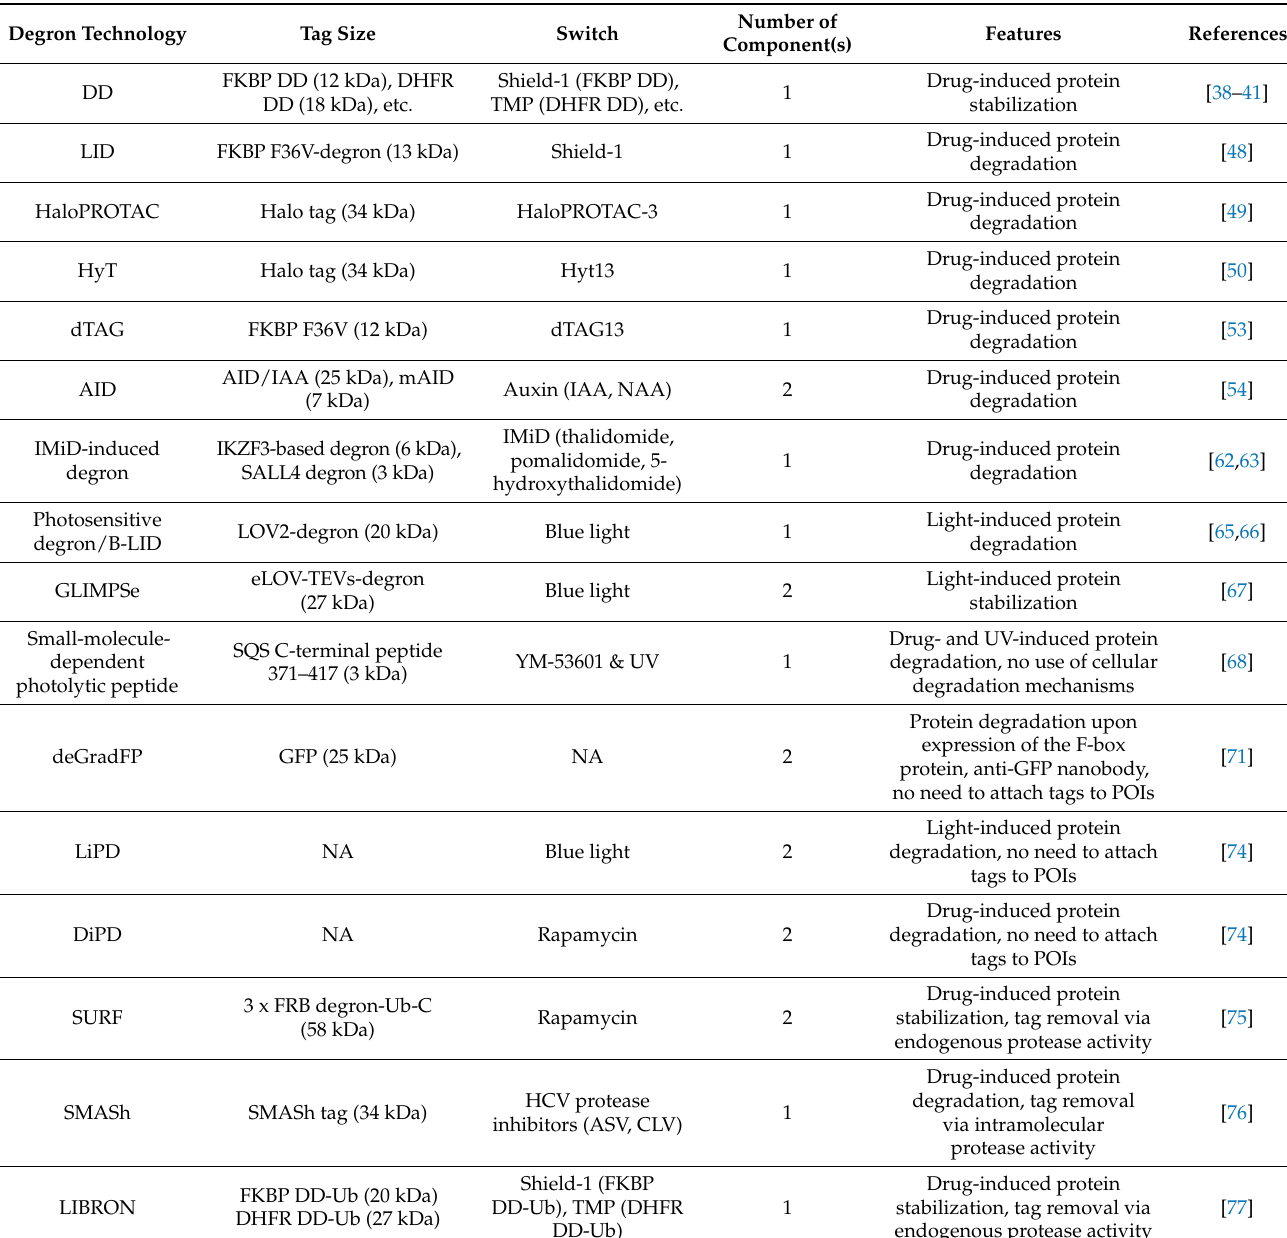
Table 2. Comparison of the technologies used for the conditional control of protein stability using genetic engineering. Degron Technology Switch